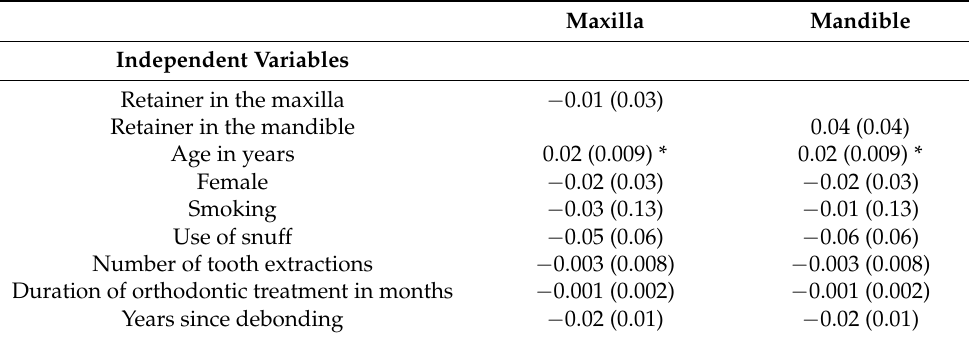
Table 10. Predictors of patient-reported orthodontic treatment result satisfaction. Maxilla